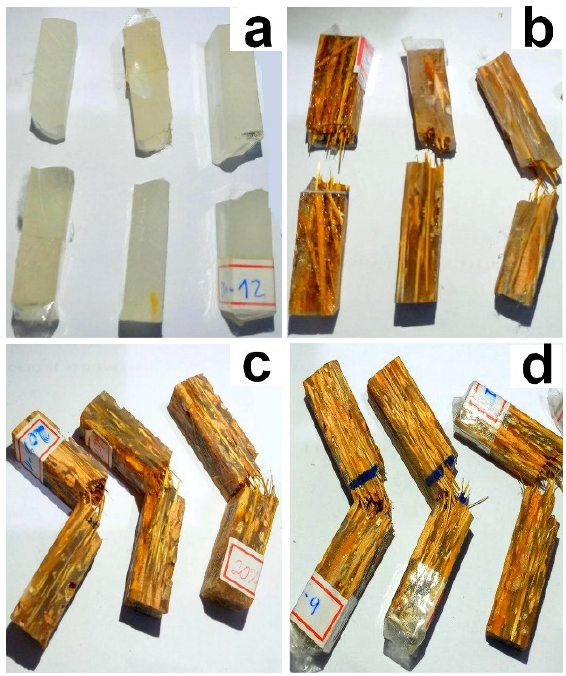
Figure 3. Izod specimens tested and categorized by caranan fiber percentage volume: ( a ) 0% (neat epoxy resin); ( b ) 10 vol.%; ( c ) 20 vol.%; ( d ) 30 vol.%.